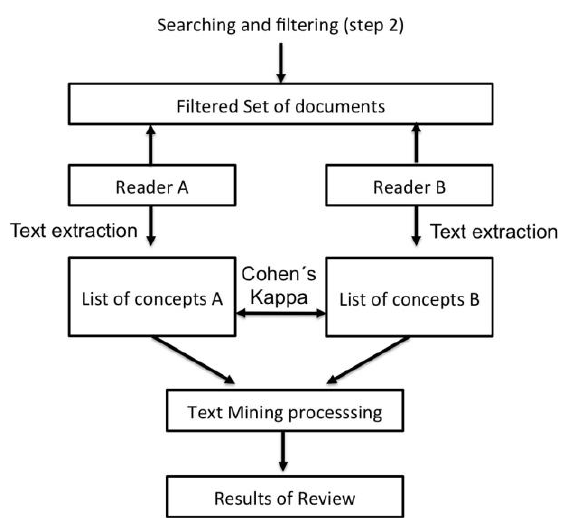
Figure 2 . Detail of in-depth reading and data